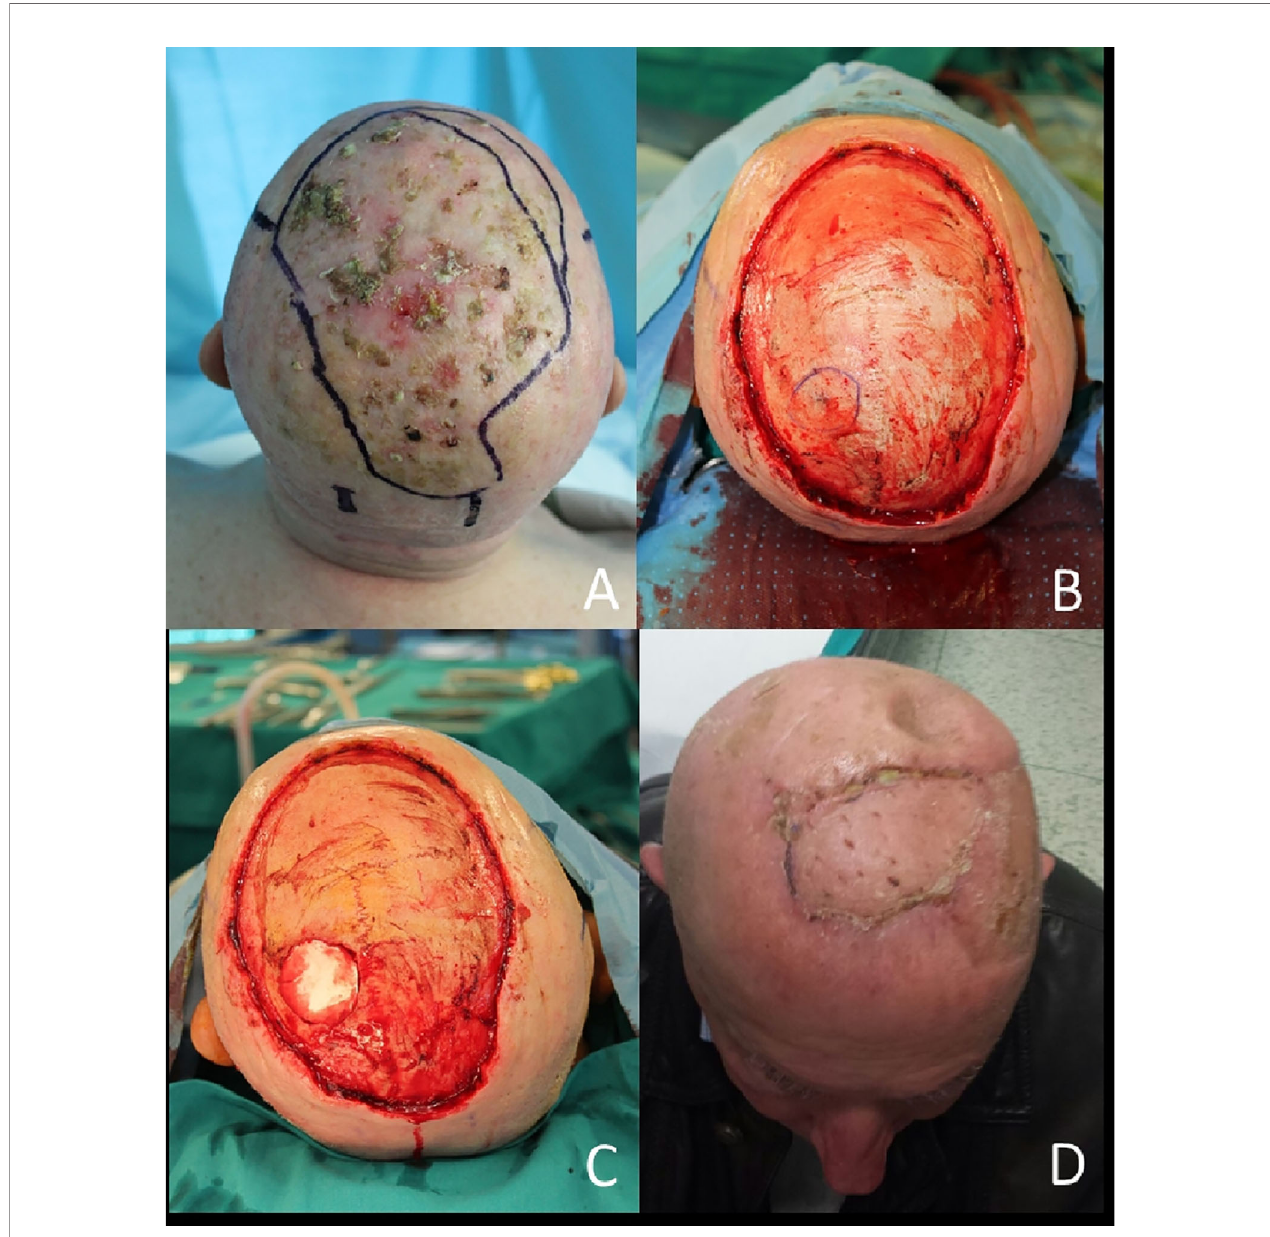
FIGURE 4 | (A) Field of cancerization on the scalp; (B) After en bloc resection, in blue outlined the tumor invasion of calvarian; (C) Bone resection complete; (D) Final result with local fl ap and skin grafts at 1